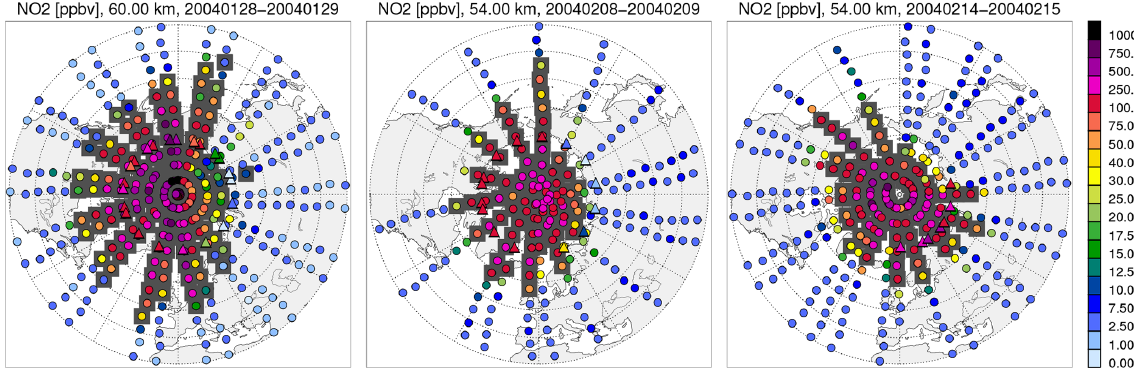
Figure 8. MIPAS (circles) and GOMOS (triangles) single observations of nighttime NO 2 at solar zenith angles ≥ 106 ◦ . Left: 60km, 28– 29 January 2004; middle: 54km, 8–9 February 2004; right: 14–15 February 2004. Grey rectangles as in Fig.